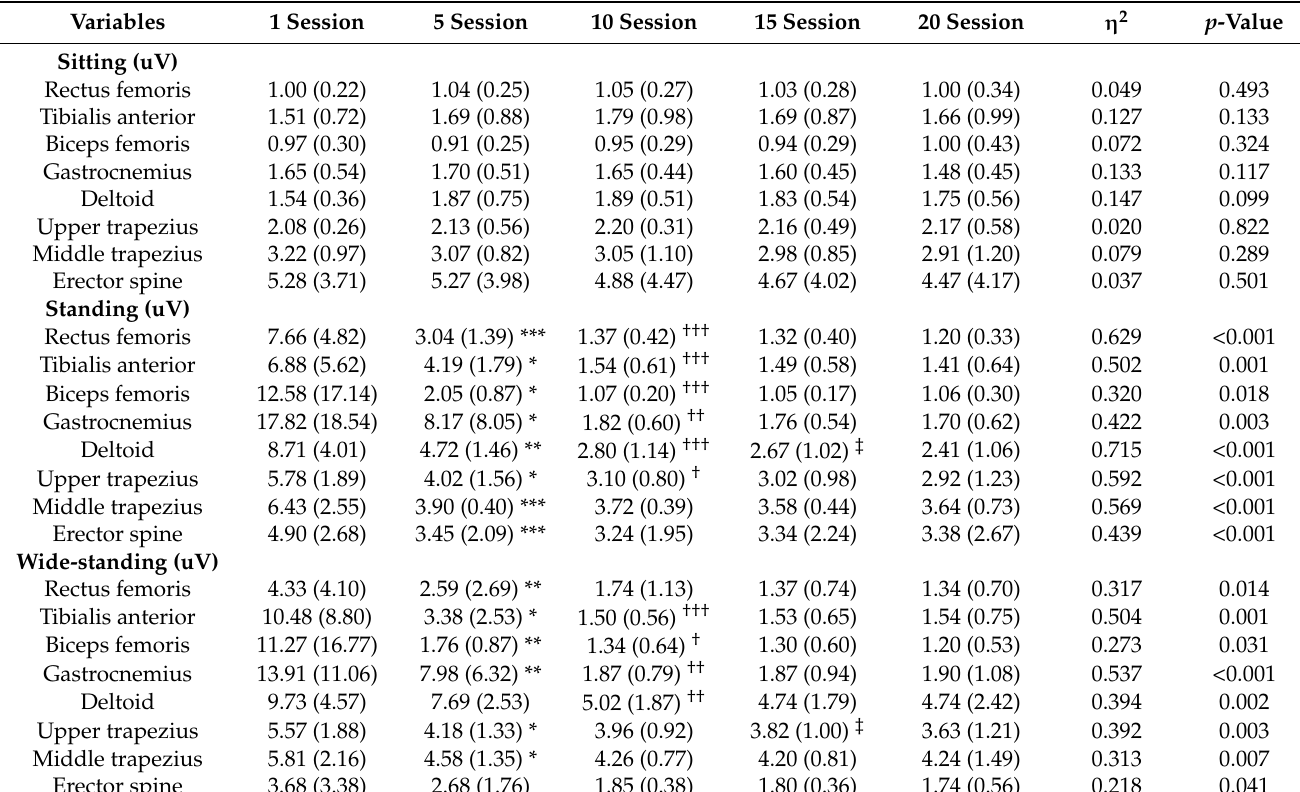
Table A1. Muscle activity in static condition during the locomotion training protocol.